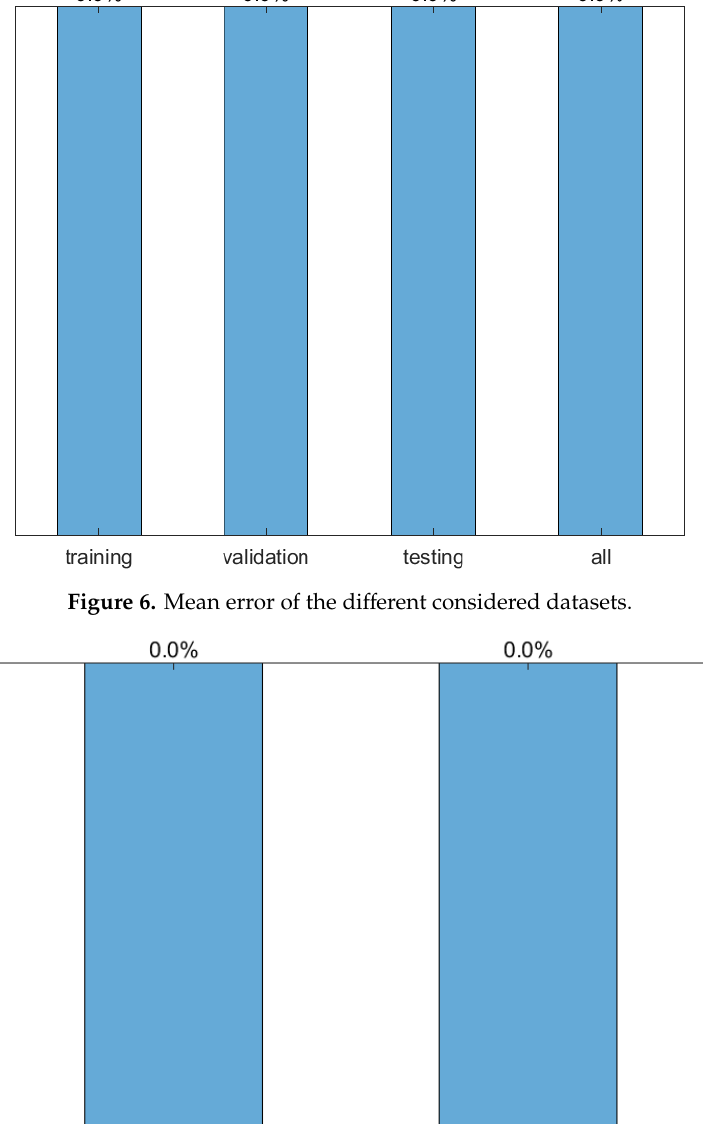
Figure 5. Comparison between predicted shear capacity and calculated shear capacity.